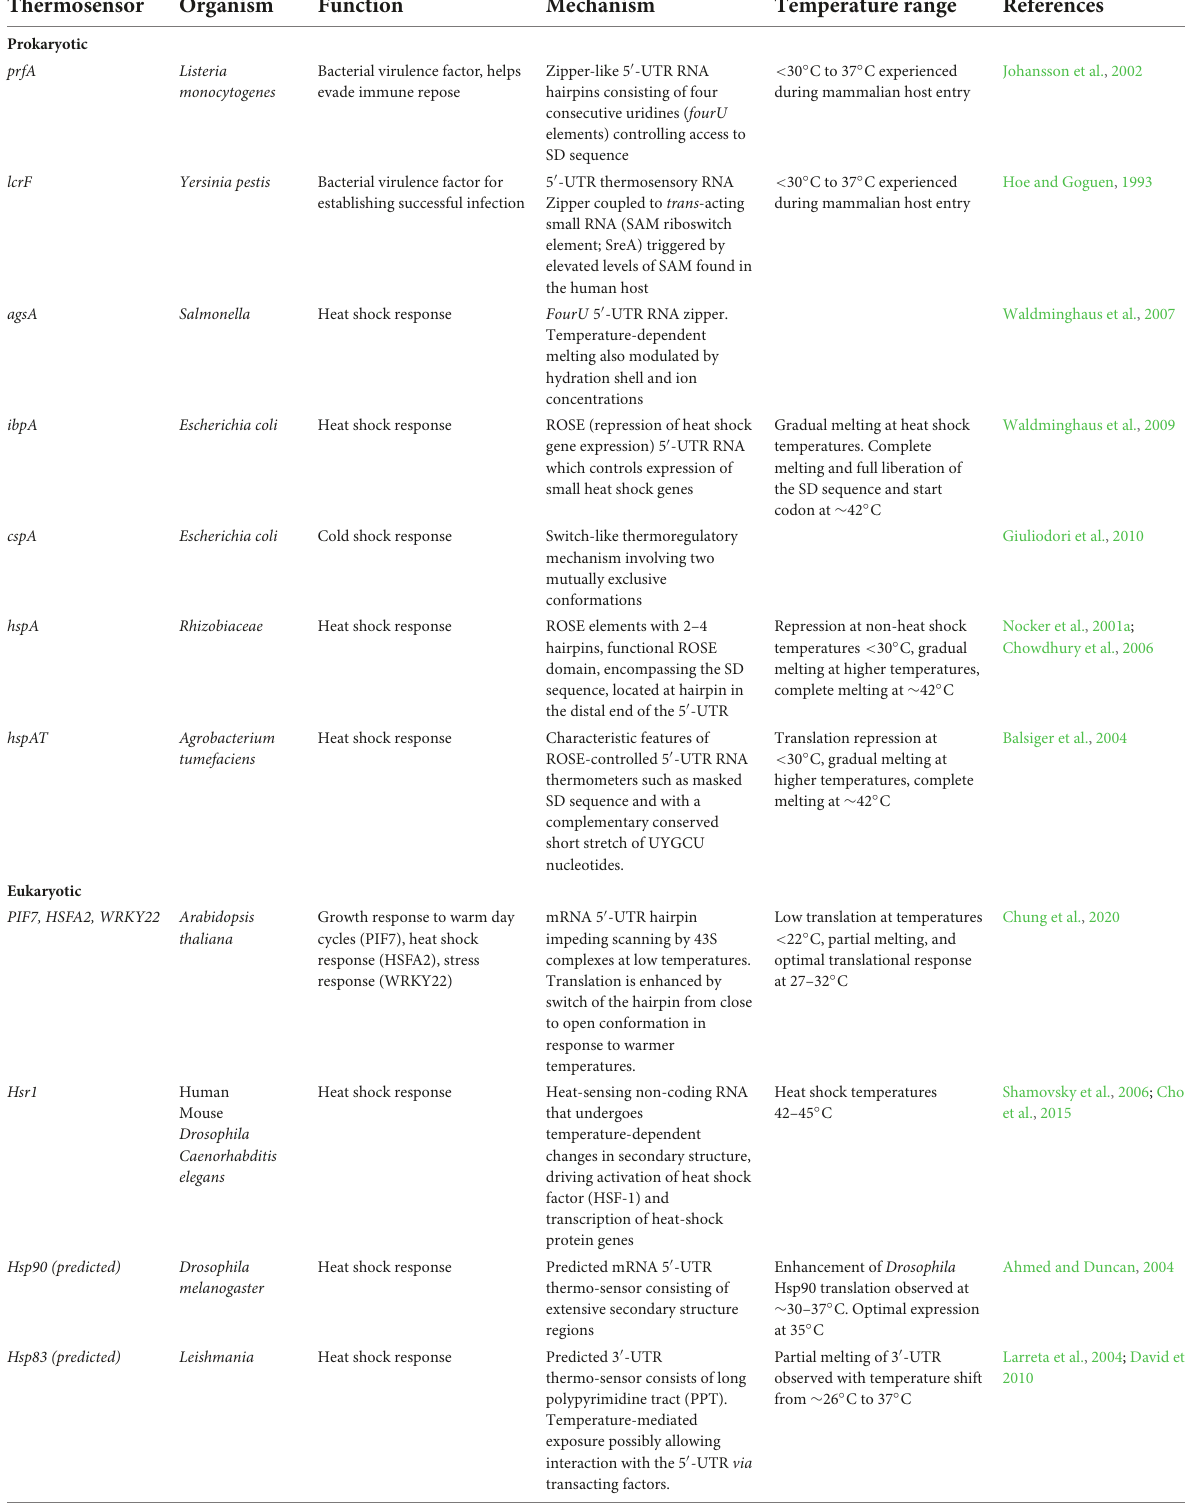
TABLE 1 Summary of known and predicted RNA structure mediated thermo-sensors discussed in this review.